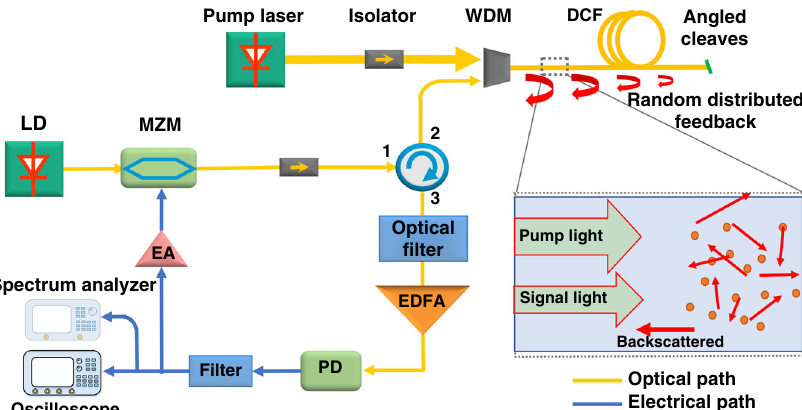
Fig. 1 Block diagram of the broadband random OEO. LD, laser diode; MZM, Mach – Zehnder modulator; WDM, wavelength division multiplexer; DCF, dispersion compensation fi ber; EDFA, erbium-doped fi ber ampli fi er; PD, photodetector; EA, electrical ampli fi er. Angled cleaving is used at the fi ber